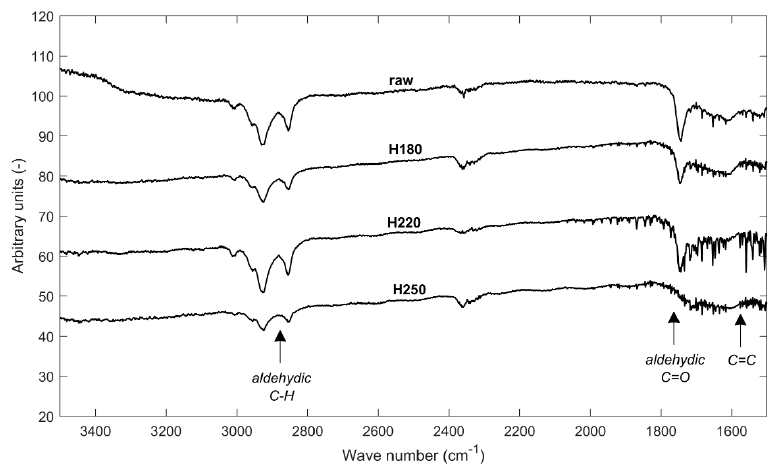
Figure 5. Fourier Transform Infrared Spectroscopy (FTIR) spectra of hydrothermal carbonization (HTC) chars and raw material.